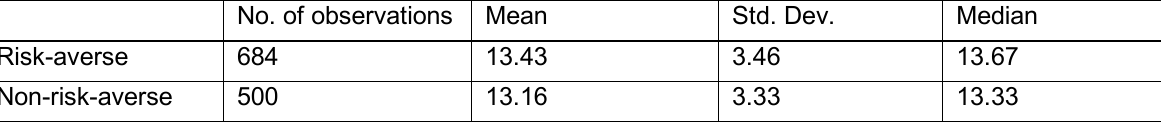
Table 11: Overall Financial Literacy Scores by Attitude Towards